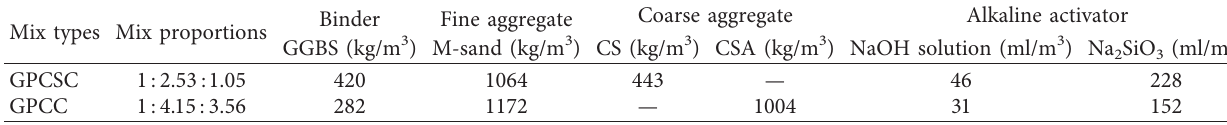
Table 2: Mix proportion of GPCSC and